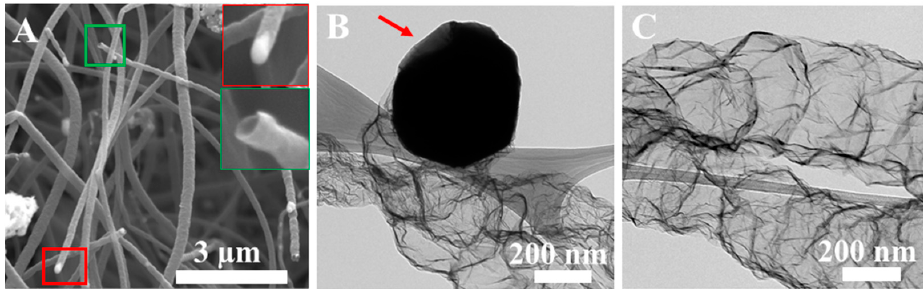
Figure 2. SEM image of ( A ) carbon nanofibers; the inset red and green outlines are the FeMNPCs attached to the tip of the tube and the cross section of a hollow nanotube, respectively; TEM image of ( B ) formation of a CNT from a FeMNPC, red arrow shows the utilised area of carbon precursors and ( C ) hollow corrugated CNT.